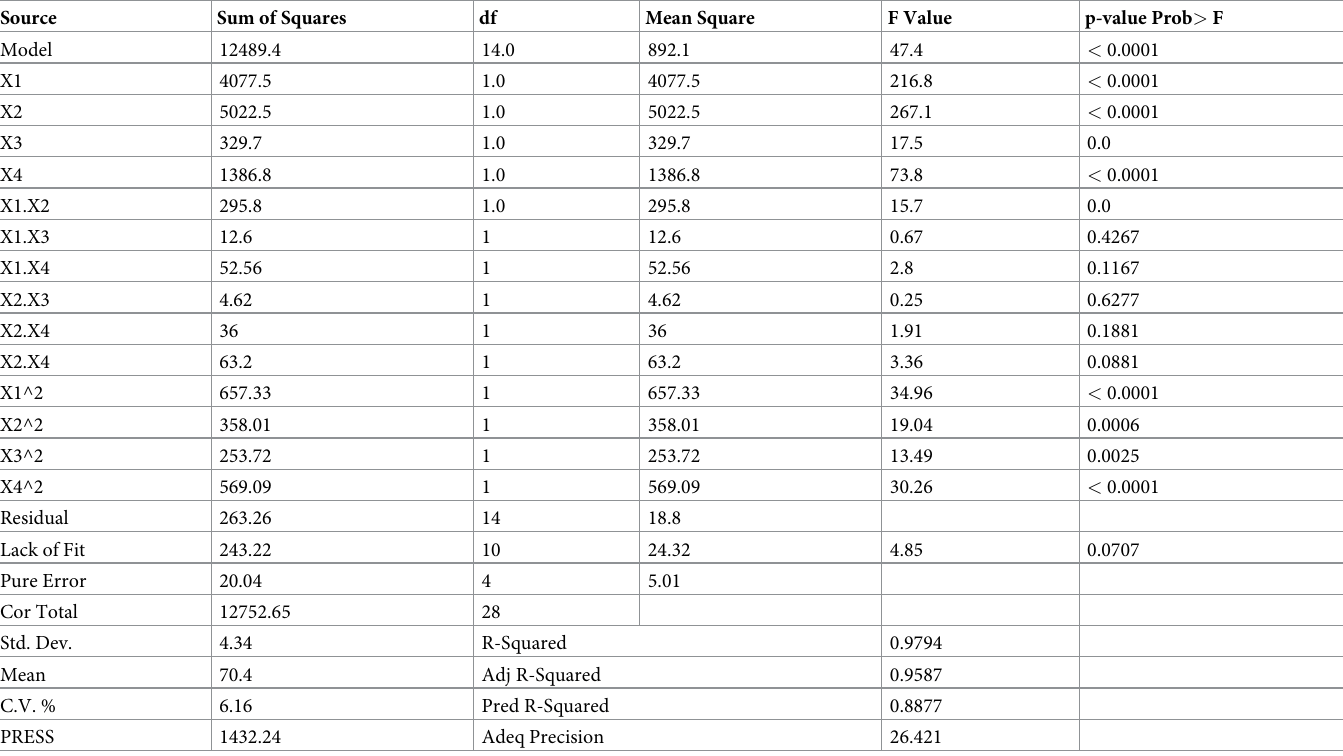
Table 5. Analysis of variance (ANOVA) for CIP